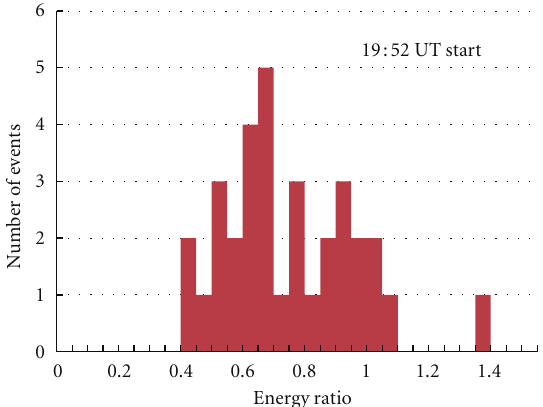
Figure 13: Energy ratio between converted protons ( E p ) versus incident neutrons ( E n ). Proton energy ( E p ) was measured using the range method by the FIB sensor, while neutron energy was estimated by flight time. We assumed that the solar neutrons departed at the same time (19:52 UT) from the Sun. There is an event beyond 1.0. However taking account of the energy resolution of the sensor, it sometimes happens.